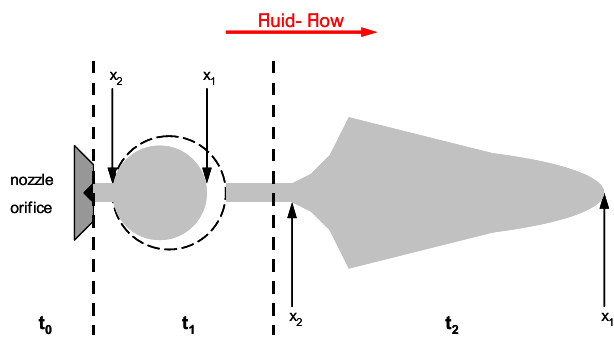
Figure 9. Schematic dispense progress over time.